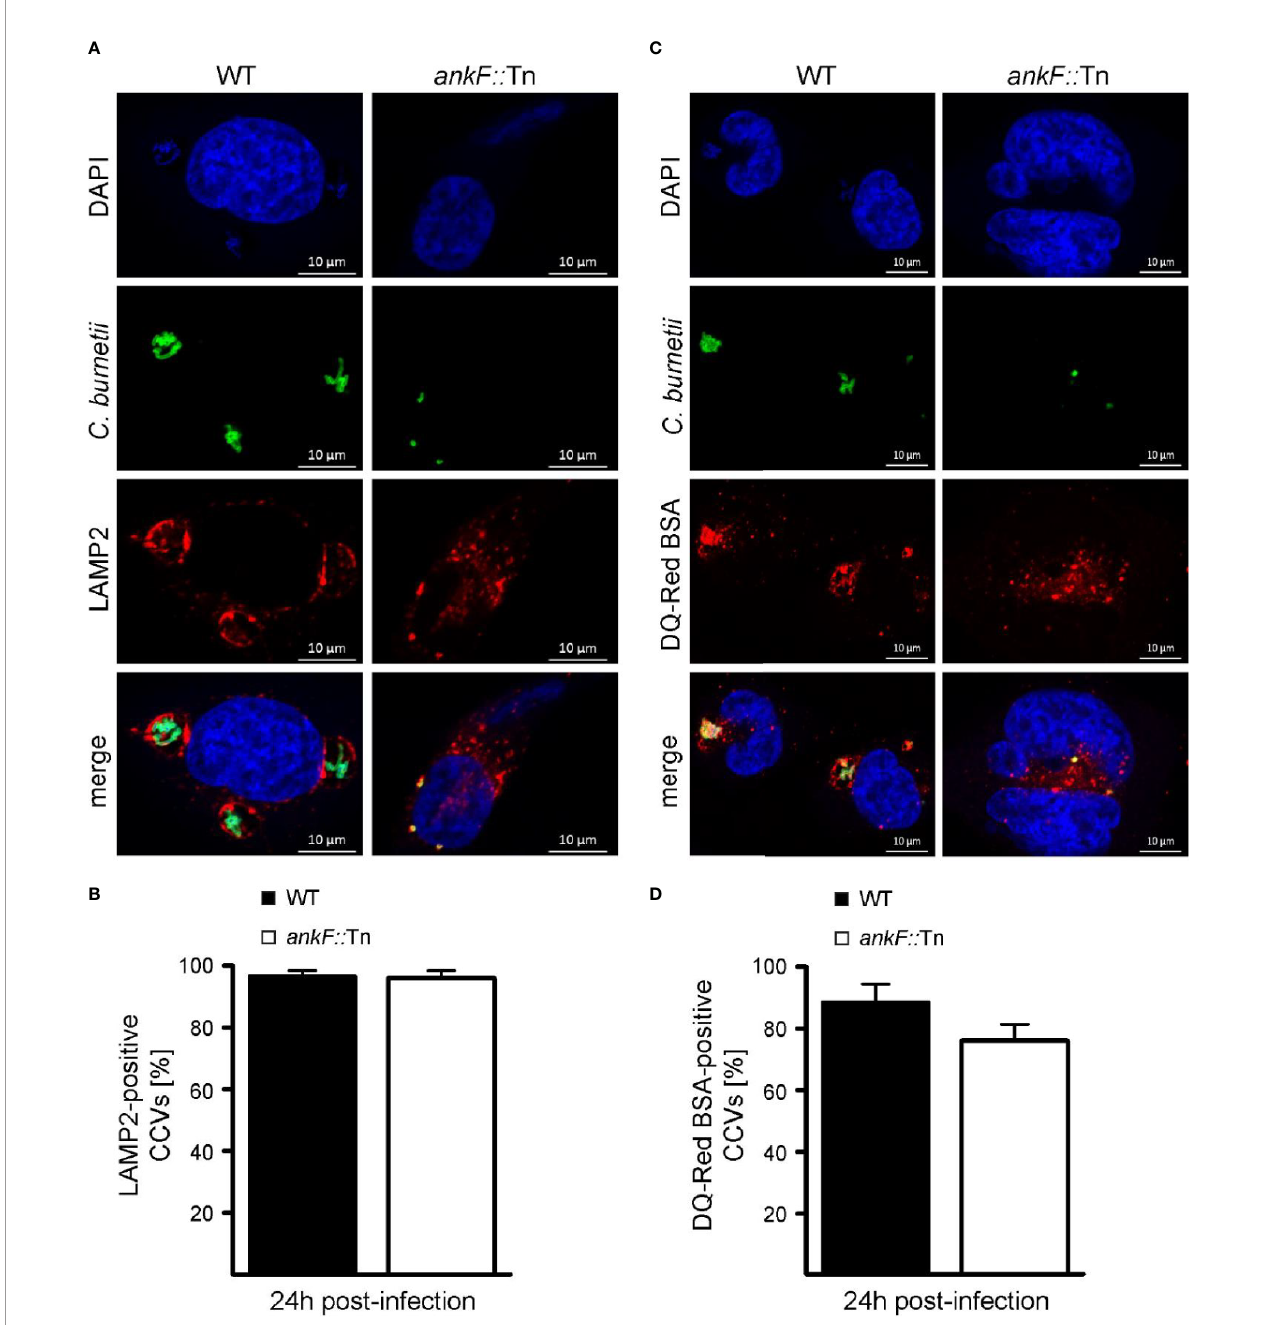
FIGURE 4 | The C. burnetii T4SS effector AnkF is dispensable for CCV maturation. (A, B) HeLa cells were infected with wild-type C. burnetii (WT) and the ankF ::Tn ( ankF ::Tn) mutant at an MOI of 50. At 24 h post-infection the cells were fi xed and stained with an anti-LAMP2 antibody (red) and with antisera against C. burnetii (green). Nuclei and bacterial DNA were stained with DAPI (blue). Cells were visualized using LSM. (A) Representative LSM images are shown. (B) 100 infected cells were analyzed for the association of LAMP2 with the CCV. Error bars represent mean standard deviations of three independent experiments. (C, D) HeLa cells were infected with wild-type C. burnetii (WT) and ankF ::Tn ( ankF ::Tn) at an MOI of 50. Cells were incubated with DQ-Red BSA for 16 h. At 24 h post-infection, the cells were fi xed and stained with antisera against C. burnetii (green). Nuclei and bacterial DNA was stained with DAPI (blue). Cleaved DQ-Red BSA emits fl uorescence (red). Cells were visualized using LSM. (C) Representative LSM images are shown. (D) 100 CCVs were analyzed for red fl uorescence using an epi fl uorescence microscope. Error bars represent mean standard deviation of three independent